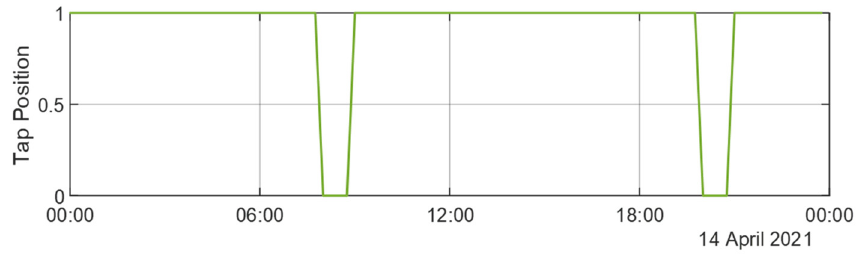
Figure 8. Estimated tap positions for the total net-demand of the OLTC at Xewkija